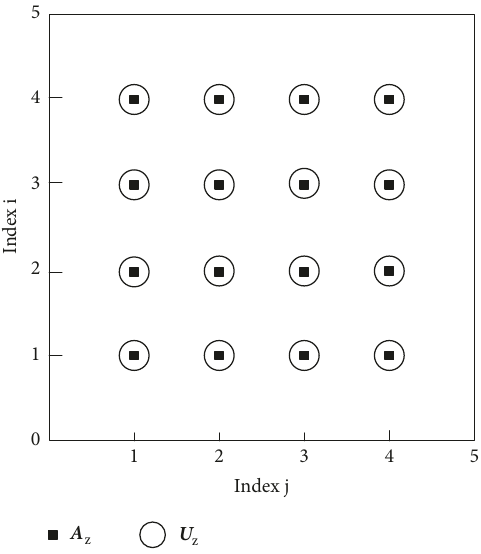
Figure 1: The spatial arrangement of the 𝑈 and 𝐴 field components in the 2D TM case.